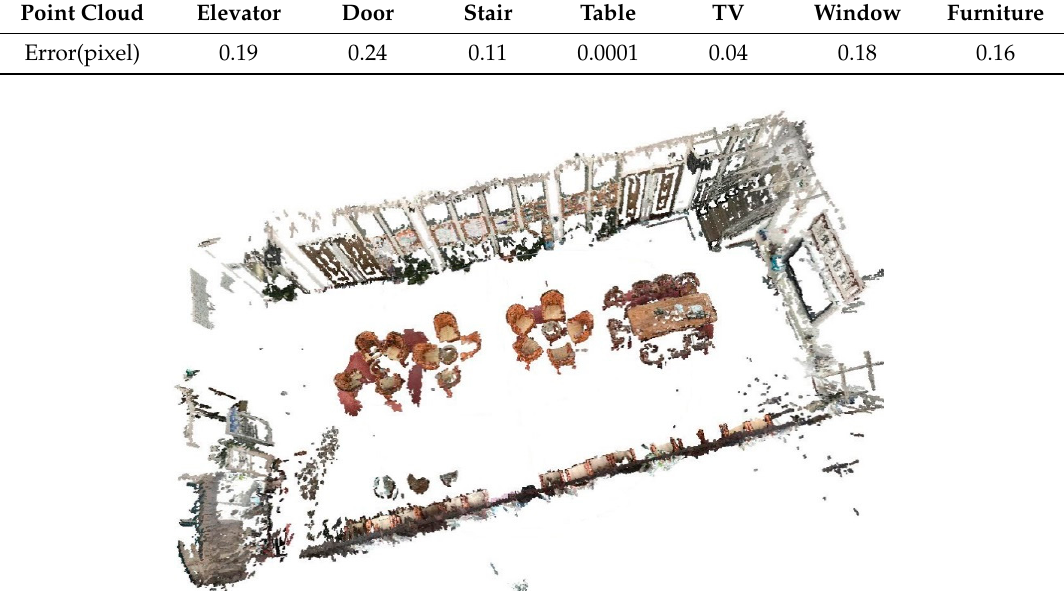
Table 4. The classification accuracy for the lobby